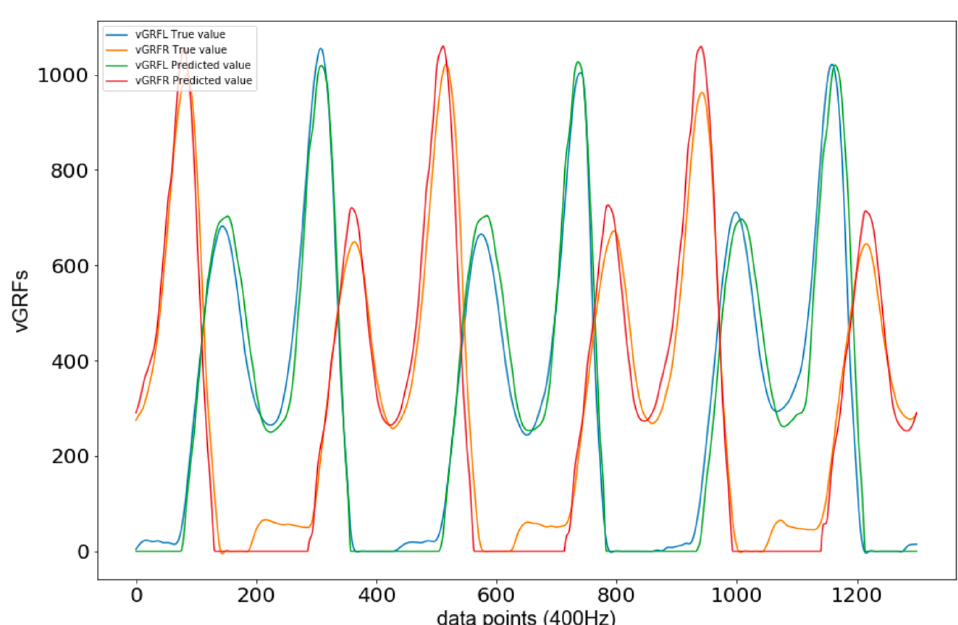
Figure 12. Glimpse of vGRF predictions generated by the LSTM neural network for test set